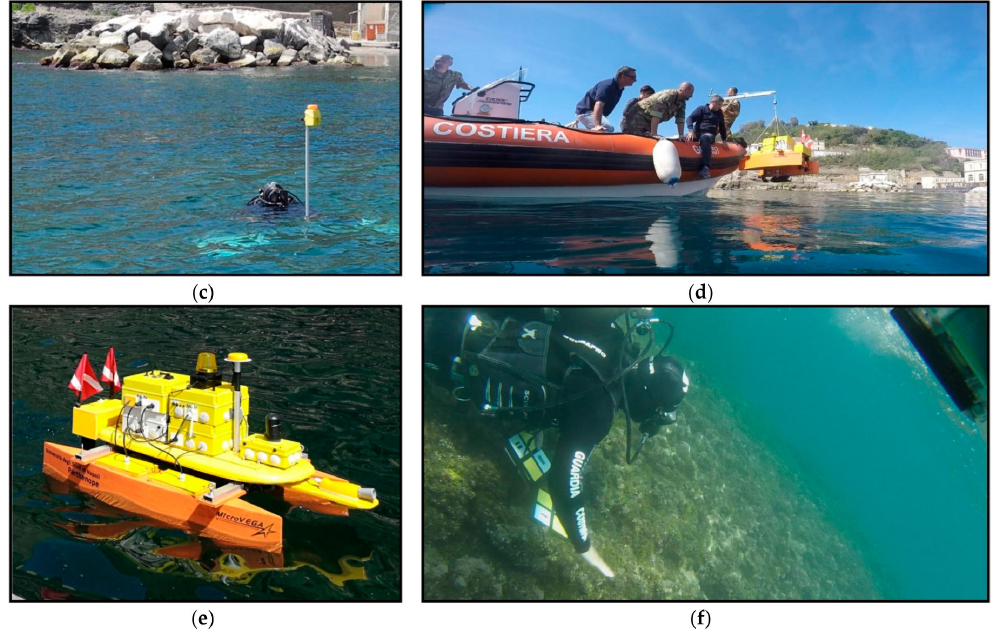
Figure 4. Direct and indirect marine surveys: ( a ) sensors installation on MicroVeGA; ( b ) Semi-submerged Roman gallery; ( c ) topographic survey of a GCP; ( d ) initial operations of the marine survey; ( e ) MicroVeGA in action; and ( f ) initial operations of the topographic survey.